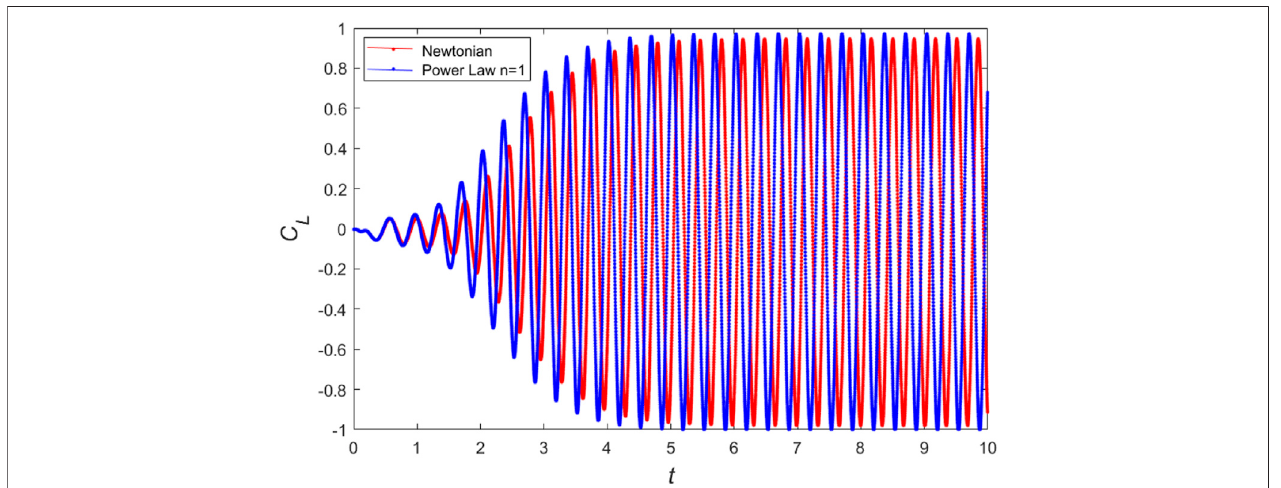
FIGURE 3 | Lift comparison test for Newtonian fl uid ( n (cid:2) 1 ) [46].